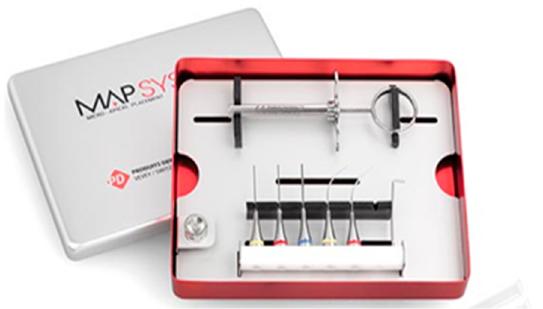
Figure 18. MAP system universal kit. (Image courtesy of Dentsply Sirona, https://www.maillefer.com/products/specialty/map-system, accessed on 27 January 2021).